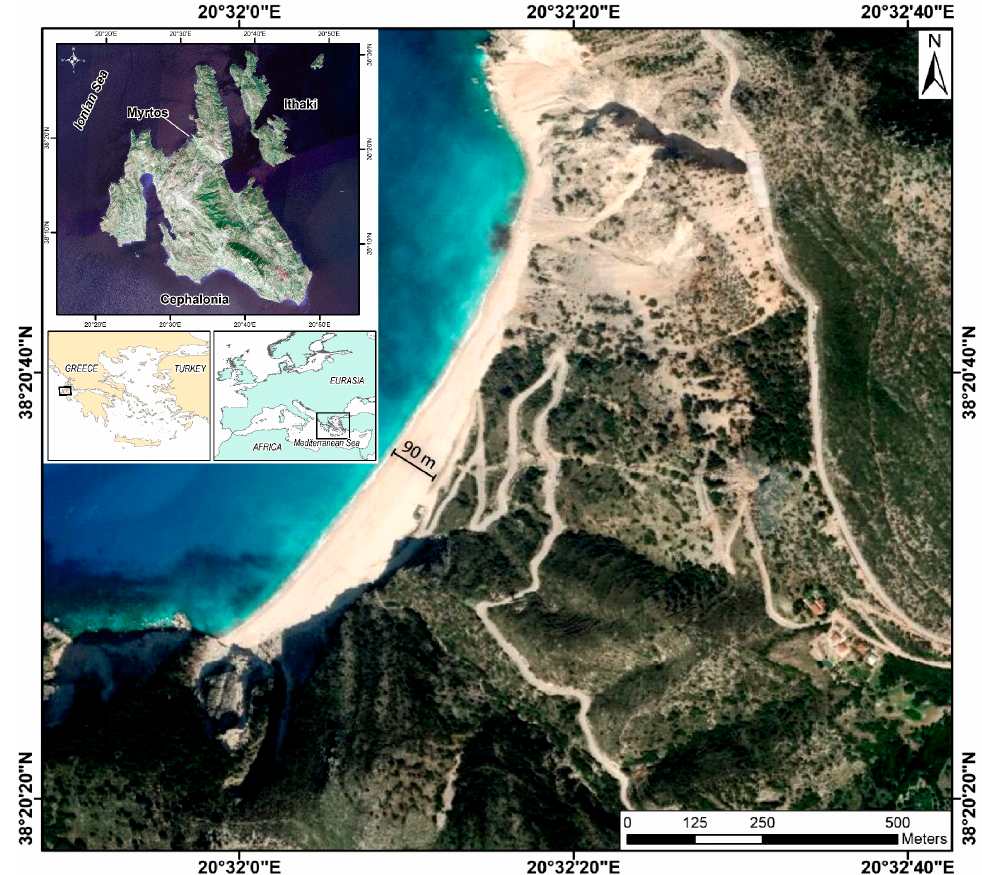
Figure 1. Location map of Myrtos beach. The insets show the study site at different scales (projected coordinate system GGRS’87, EPSG:2100).